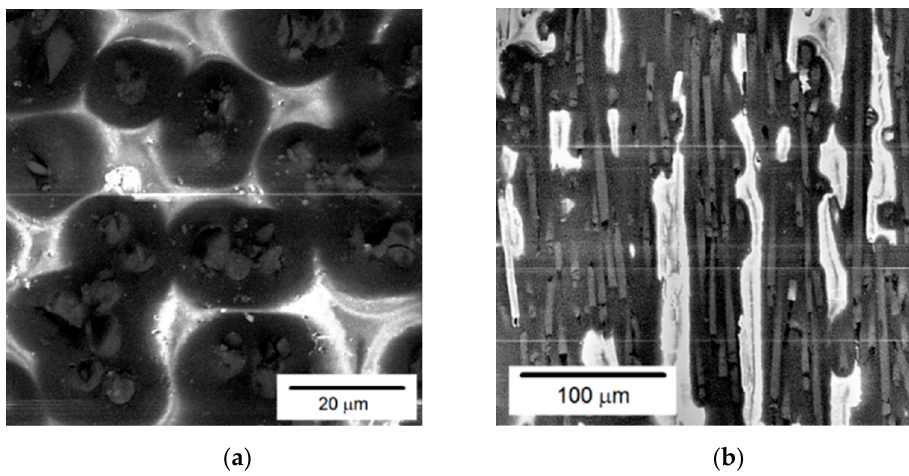
Figure 9. The microstructure of short-fiber reinforced PA6 with 30% carbon-fiber mass fraction along the following orientations: ( a ) 0°; ( b ) 90°.